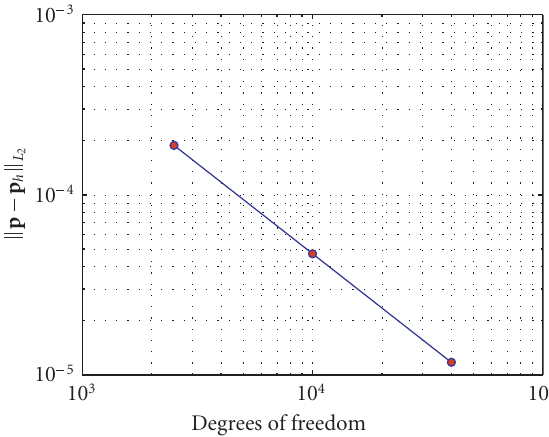
Figure 4.7 . Example 4.2: convergence of the discretization scheme. L 2 error versus the degrees of freedom in the mesh. We are observing (cid:4) p − p h (cid:4) L